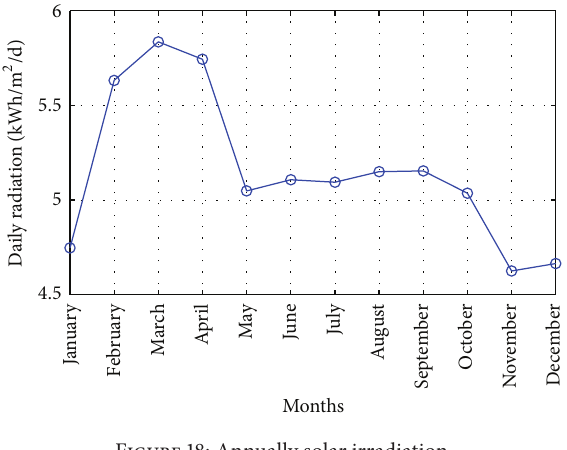
Figure 18: Annually solar irradiation.